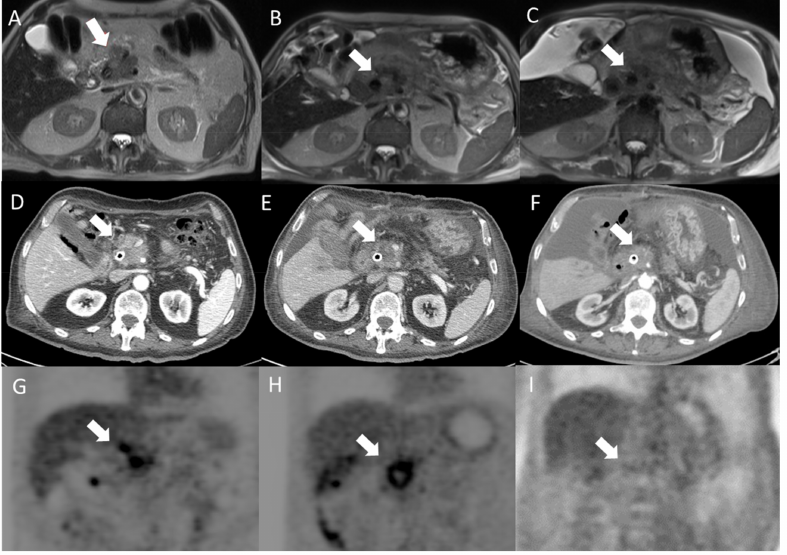
Figure 5. Head pancreatic cancer patient treated with fixed geometry. Before treatment, the arrow identifies the lesion on the HASTE T2-W sequence ( A ); after treatment the lesion (arrow) shows non-significant differences in signal intensity and size in ( B) (one month after treatment) and in ( C ) (six months after treatment). In addition, non-significant difference on the CT study between pre- ( D ) and post-treatment was observed both after one month ( E ) and after six months by ECT ( F ). Instead, PET evaluation between pre- ( G ) and post-treatment detected a reduction of glucose uptake both after 1 month ( H ) and after 6 months ( I ) by ECT. According to data, the patient, after one month and after six months, was classified to be in stable disease by